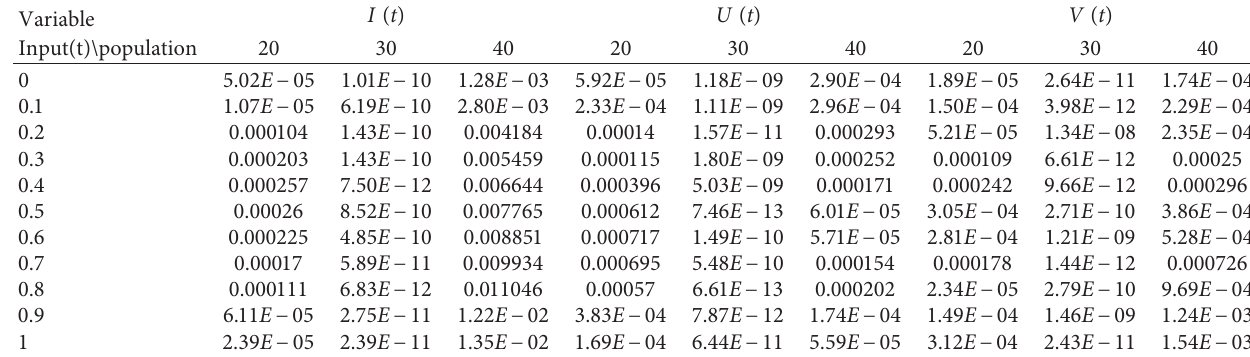
Table 9: Problem 5: analysis based on the variation of population size.